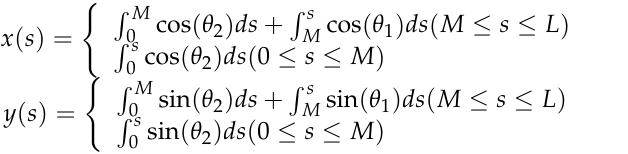
Figure 6. Experimental diagram of EI parameter fitting process. We do not add a curvature sensor to obtain the soft arm bending angle  in practi- cal applications. We drive the soft arm by connecting the steering gear and cable to solve this problem, as shown in Figure 5a. This paper uses steering gear rotation angles of 0 – 270 degrees, so the pulse width modulation (PWM) can be used to control the steering gear rotation angle. The PWM control interval is selected from 500 to 2500, and the posi- tion of the intermediate duty cycle is 1500. In other words, a 0-degree steering gear angle